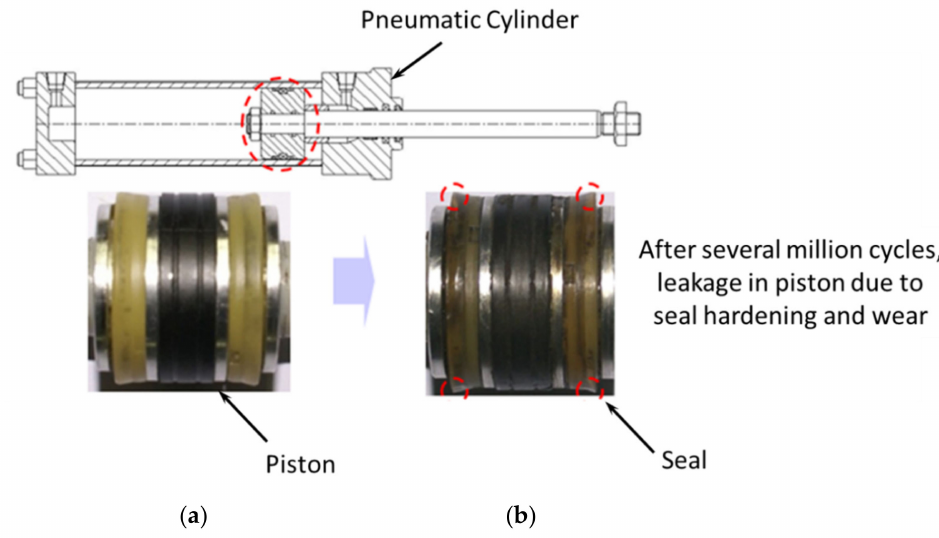
Figure 9. Failed piston seal in field: ( a ) initial state ( b ) final